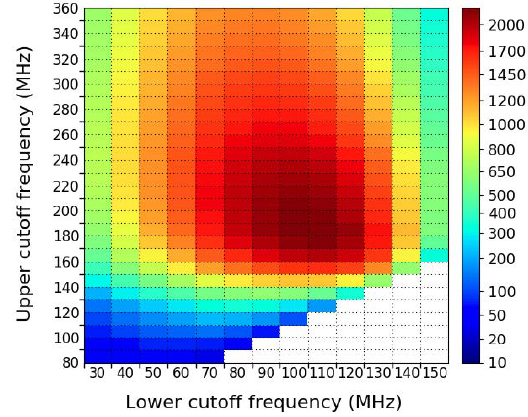
Figure 9. Signal-to-noise behaviour at various frequency bands, for one typical shower induced by a 10 PeV gamma-ray primary with zenith angle of 61 degree. It represents the SNR including the realistic noise situation at the South Pole plus a thermal noise of 40K (SKALA